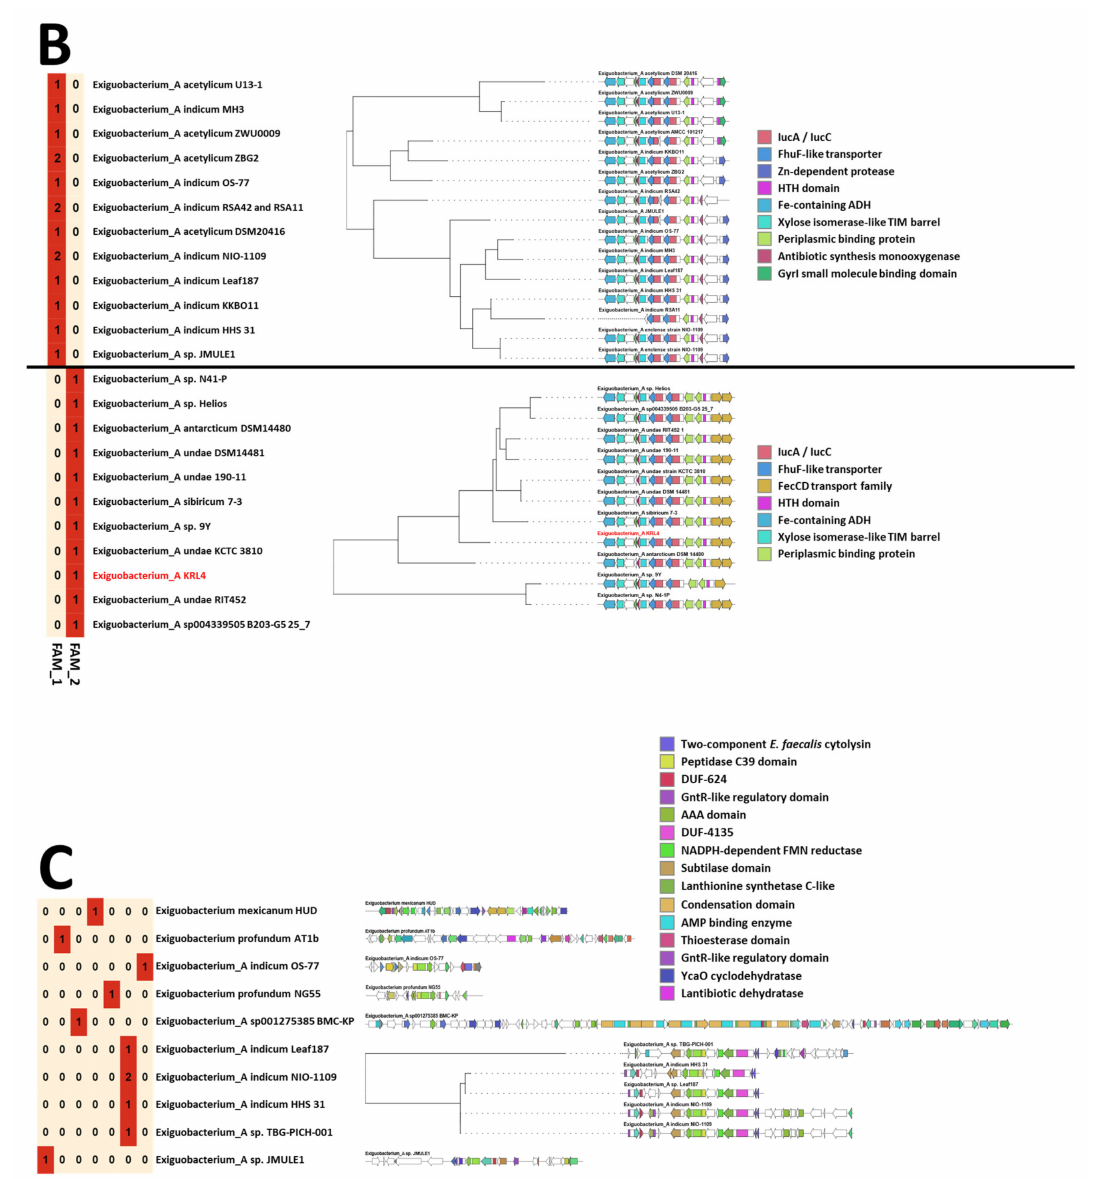
Figure 3. Comparison of terpene ( A ), siderophore ( B ) and ( C ) RiPP pathways identified in Exiguobacteraceae including KRL4. Tables show the presence/absence of pathways in Exiguobacterium or Exiguobacterium _A species while gene cluster families (GCF) are shown in the maps on the